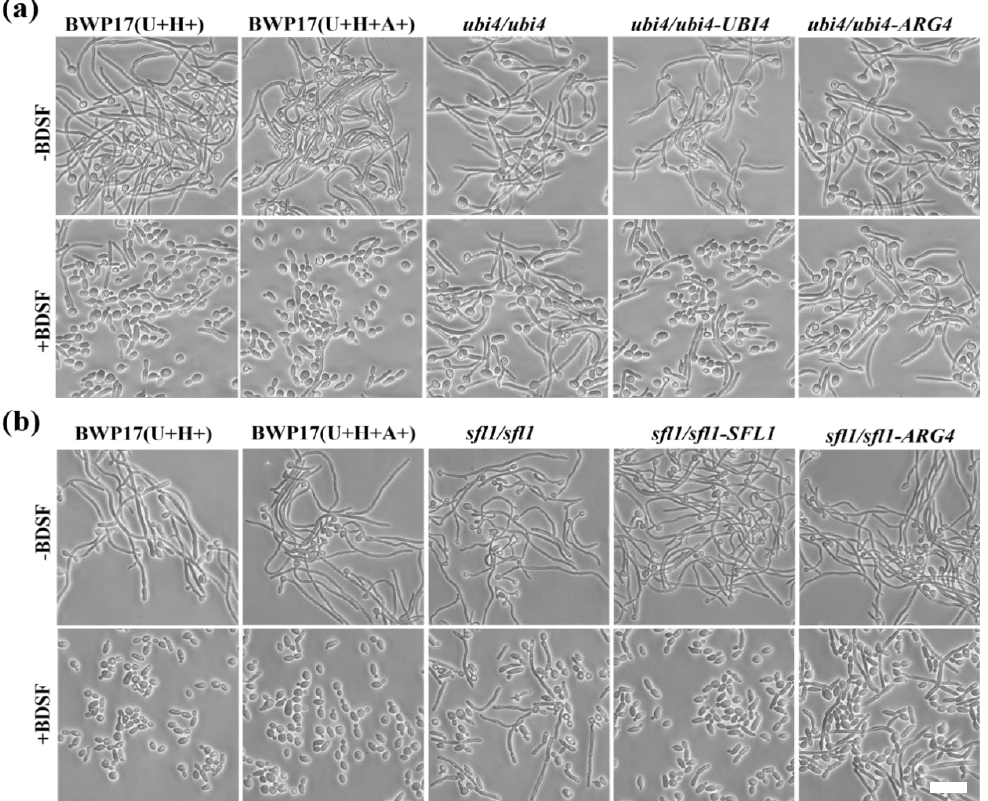
Figure 3. ( a ) ubi4∆/∆ and ( b ) sfl1∆/∆ mutants exhibited BDSF resistance. Cells were cultured in YPD medium and induced for hyphal formation with 5% FBS at 37 °C for 4 h in the presence or absence of 150 μM BDSF. Bar, 15 µm.